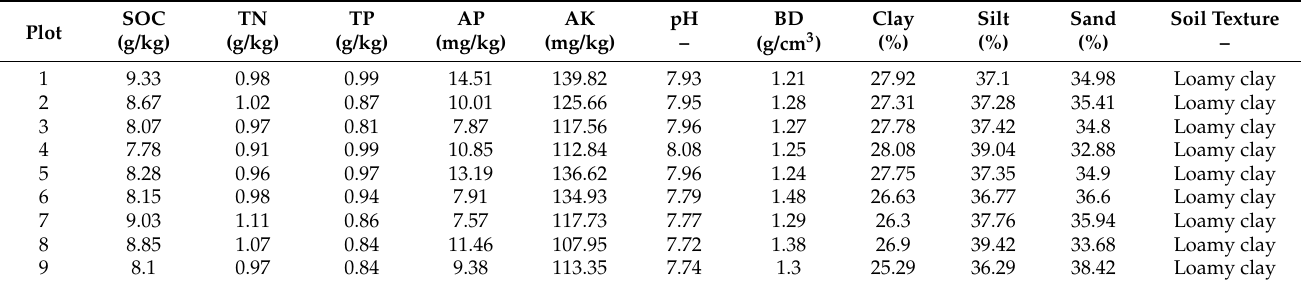
Table 3. Soil properties of experimental